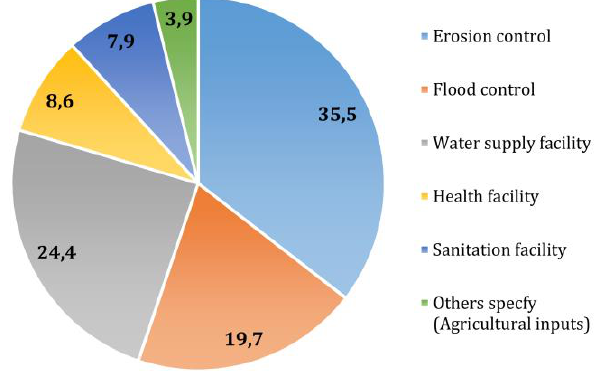
Fig. 4. LEEMP projects within the study